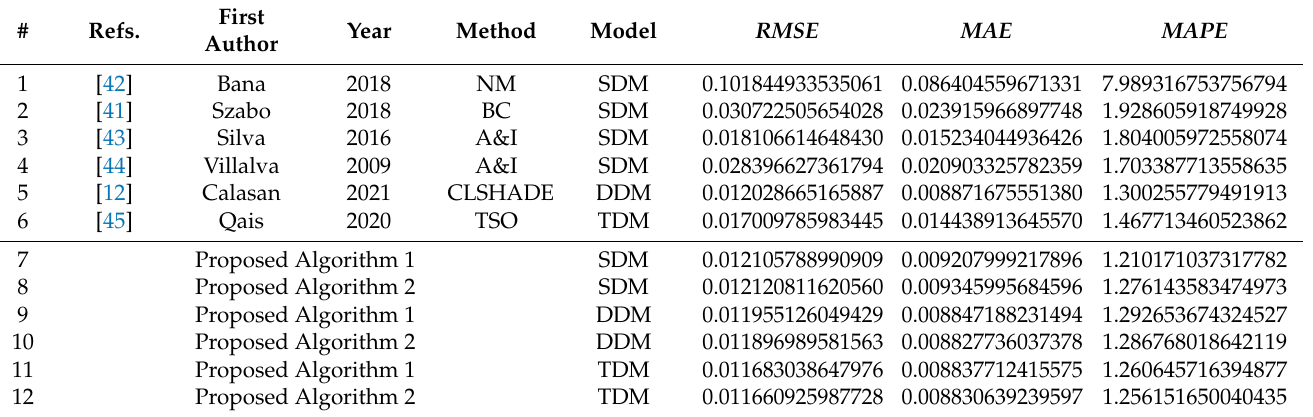
Table 3. Numerical results obtained for the Solarex MSX–60 PV solar module.